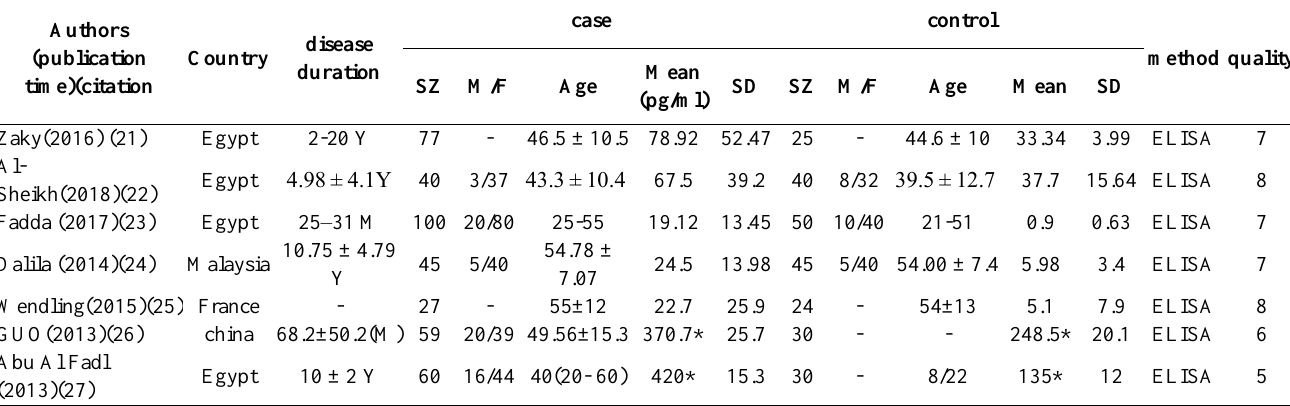
Table 1: Characteristics of included studies that compared levels interleukin 23 in healthy and Rheumatoid Arthritis patients